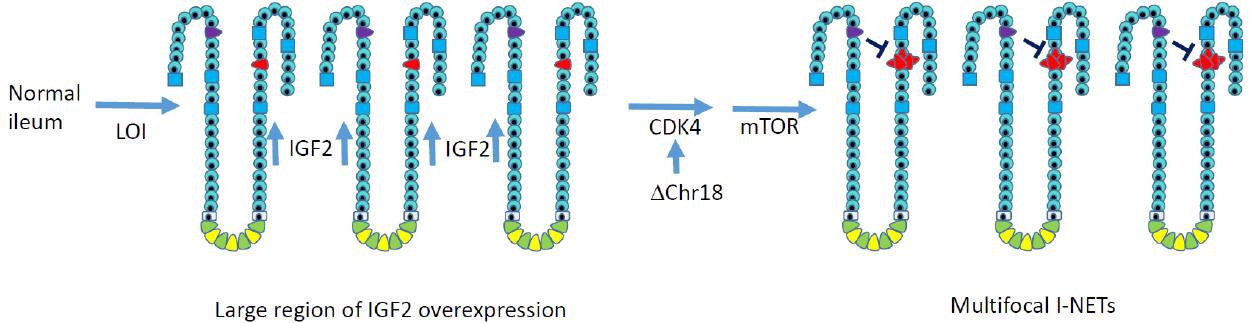
Figure 2. A working model for genetic events that lead to multifocal ileal NETs. Notably, these alterations are not caused by point mutations, which are rare in I-NETs. Overexpression of the growth factor IGF2 across a large region of the ileum occurs due to zonal loss of imprinting, which should increase the proliferation of enterochromaffin cells (red) in a number of intestinal crypts. Chromosome 18 loss decreases expression of resident gene MIR1-2, which normally suppresses CDK4 to maintain the RB1 tumor suppressor pathway. No recurrent genetic cause for mTOR activation has been elucidated in I-NETs, but mTOR inhibitors are clinically beneficial for I-NET patients. Even after tumorigenic events occur, the growth of primary ileal NETs often remains slow, possibly due to local production of the growth inhibitor somatostatin by neighboring enteroendocrine cells, which are shown in purple.